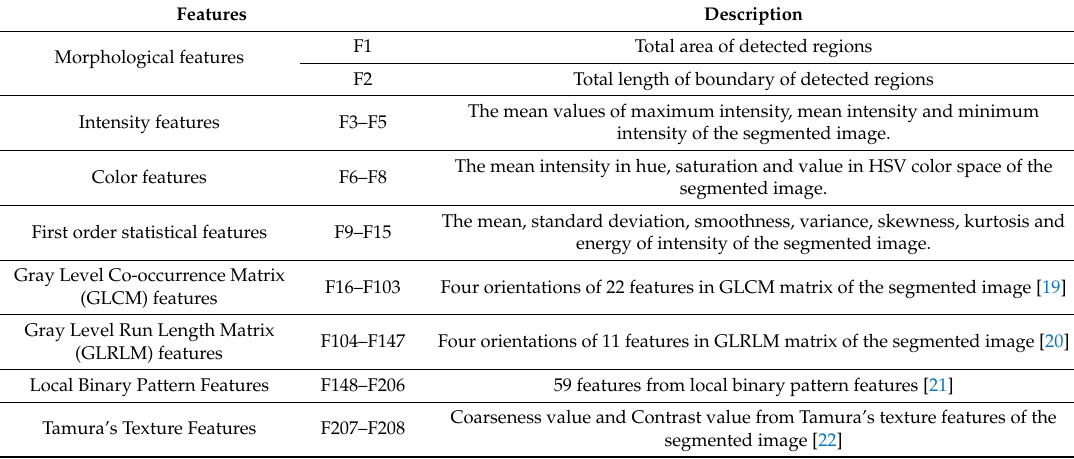
Table 1. Features extraction and its